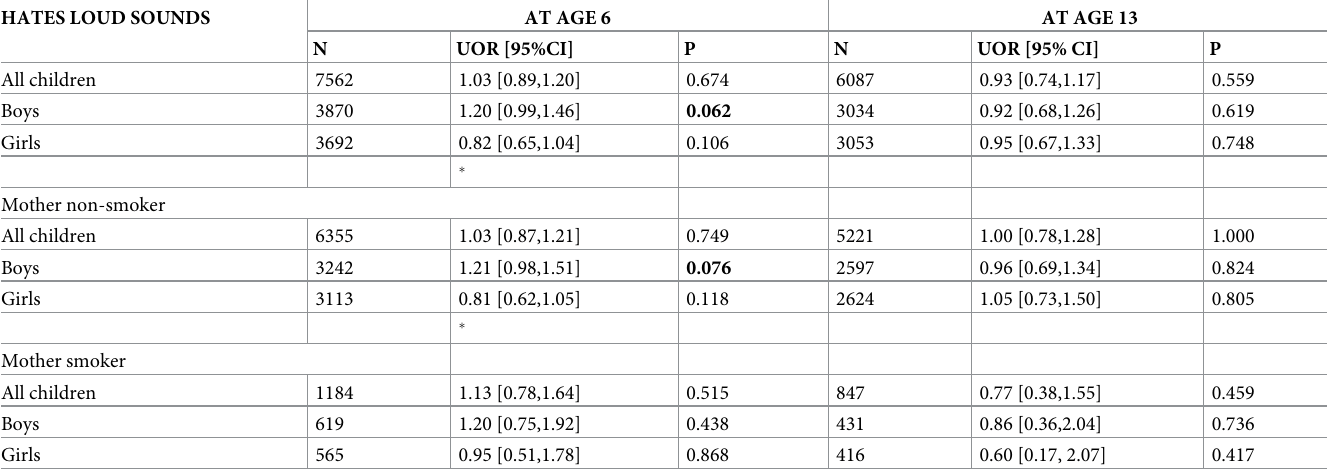
Table 1. Unadjusted risk of the child hating loud sounds at ages 6 and 13 if the maternal grandmother had smoked in pregnancy. [P values < 0.10 are in bold]. HATES LOUD SOUNDS AT AGE